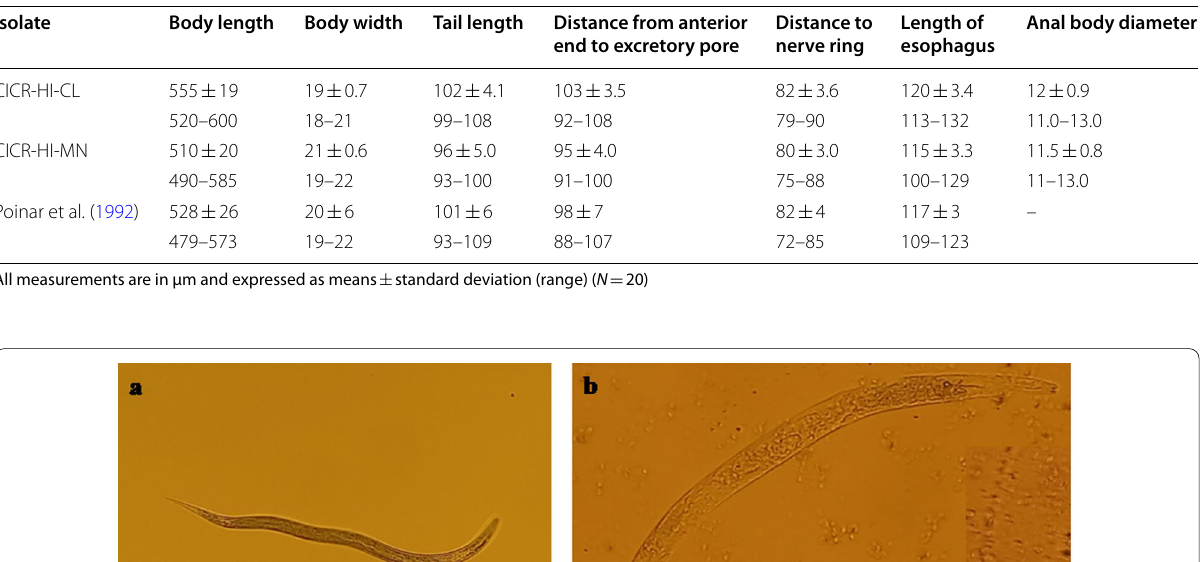
Table 2 Morphometrics data for H. indica (CICR‑HI‑CL and CICR‑HI‑MN strains) infective juveniles compared with original description Isolate